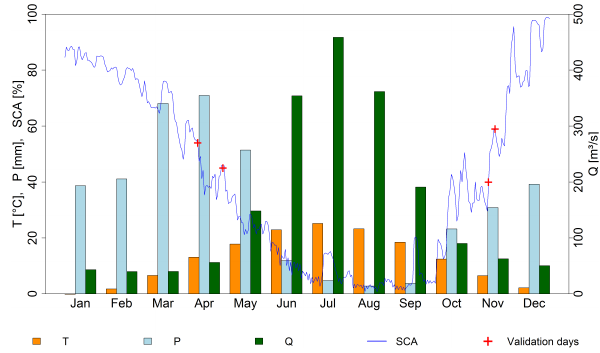
Figure 2. Monthly average air temperature (T), cumulative precipi- tation (P), discharge (Q) and SCA dynamics in the Zerafshan basin. T, P and Q means are based on data for the period from 1930 un- til 2008. Daily SCA is for 2004 obtained from MODIS and cloud eliminated using Gafurov and Bárdossy (2009). Temperature (0 ◦ C in January) and precipitation data are from the Pendjkent station (1016ma.s.l.), and discharge is measured at the Dupuli gauge (see Fig.